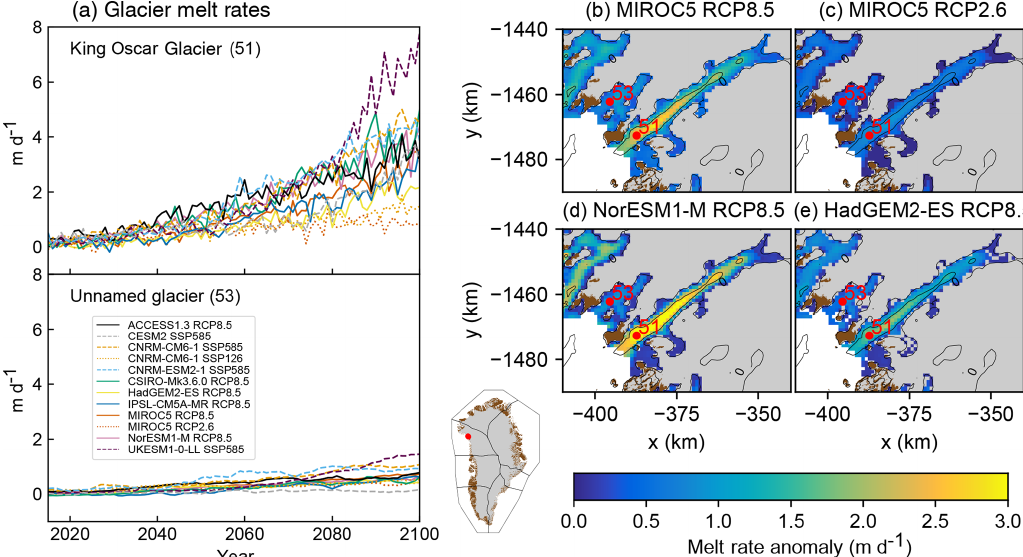
Figure 10. Melt rate anomalies (md − 1 ) for selected Greenland ice sheet glaciers under the RCP2.6, RCP8.5, SSP1-2.6, and SSP5-8.5 scenarios. (a) Time series of mean melt rate anomaly over the 21st century and mean melt rate anomaly over the time period 2081–2100 for (b) MIROC5 under RCP2.6, (c) MIROC5 under RCP8.5, (d) NorESM1-M under RCP8.5, and (e) HadGEM2-ES under RCP8.5. The bedrock contour from Morlighem et al. (2017) is shown as black lines; gray indicates ice sheet mask. Red numbers indicate King Oscar Glacier (51) and the unnamed glacier (53) discussed in the text. Note that for HadGEM2-ES missing pixels are due to bias correction making ocean thermal forcing in some of the cooler models slightly negative, resulting in no melt rate anomaly. The calculation of melt rate anomaly assumes that the ice sheet thickness and terminus position do not evolve with